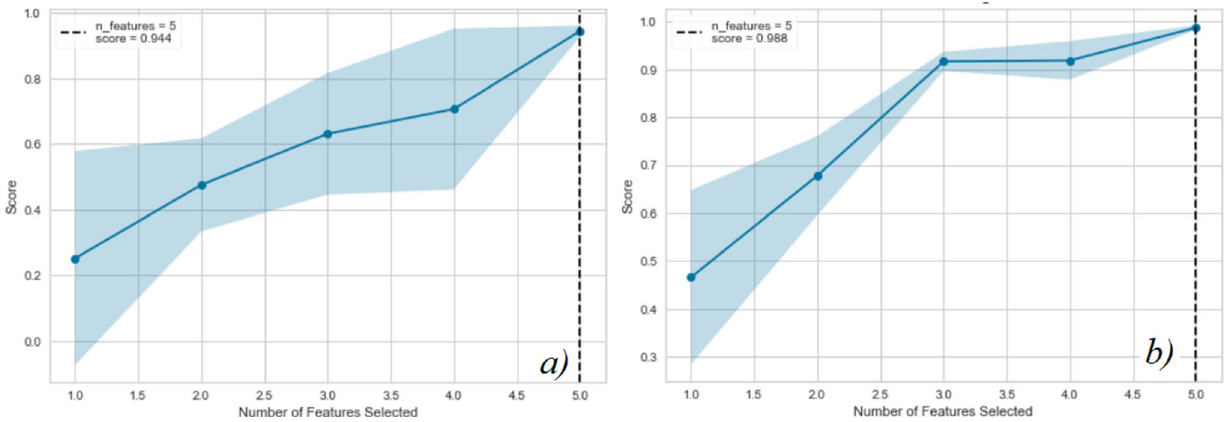
Fig. 10 Recursive Feature elimination analysis for XGB model for a C